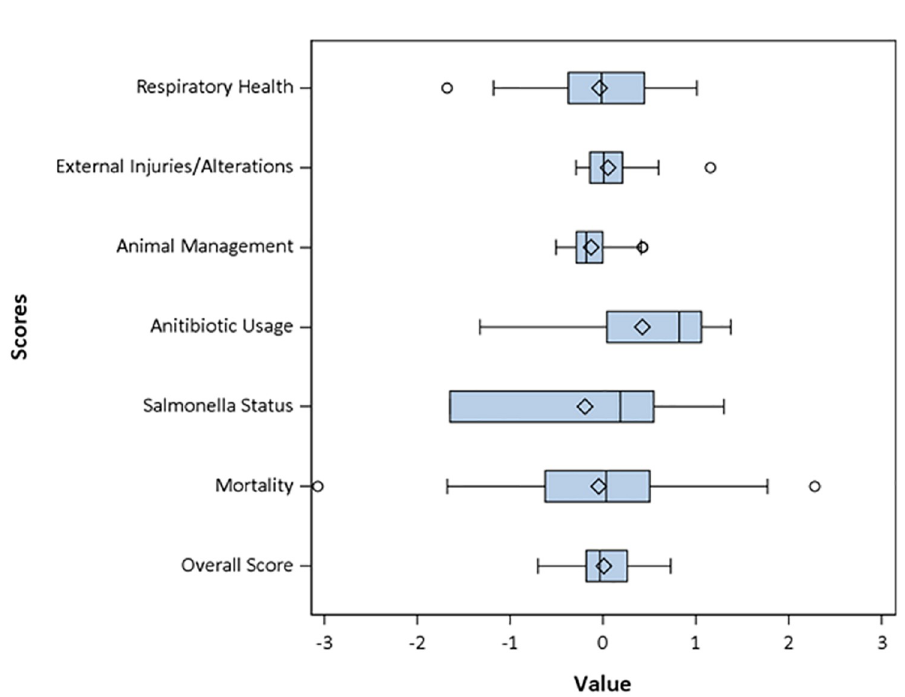
Fig 5. Distribution of the scores of farms included in the field validation exercise.